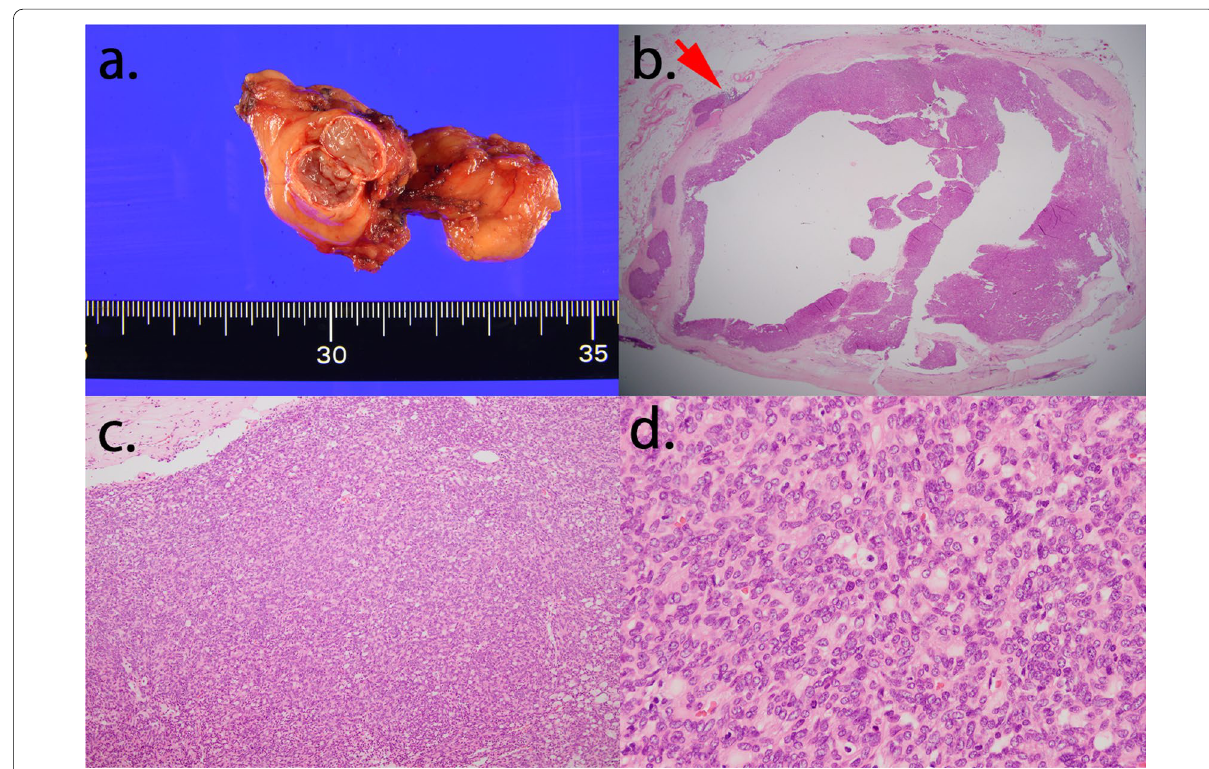
Fig. 2 a Macroscopic image of the excised thymic tumor. b – d Hematoxylin and eosin staining of the anterior mediastinal tumor. Microscopic invasion into the surrounding adipose fatty tissue beyond the capsular portion is noted only in one part of the tumor ( b , arrow). Tumor cells with relatively poor atypia and round nuclei are seen to grow in a fascicular pattern. The tumor shows findings of hypercellularity ( c , d